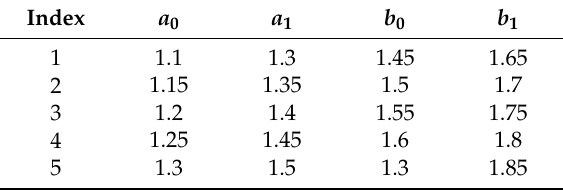
Table 8. Different Values of a 0 , a 1 , b 0 , and b 1 for sensitivity analysis of (0, 1).